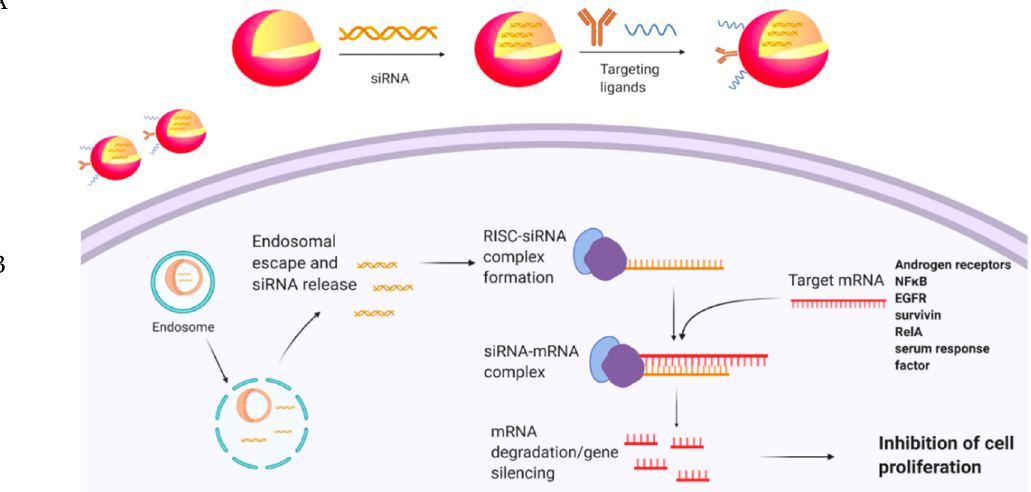
Figure 1. ( A ) Encapsulation of siRNAs in nanoparticles, modified with targeting ligands. ( B ) Delivery and release of siRNAs to desired cells, leading to gene silencing.